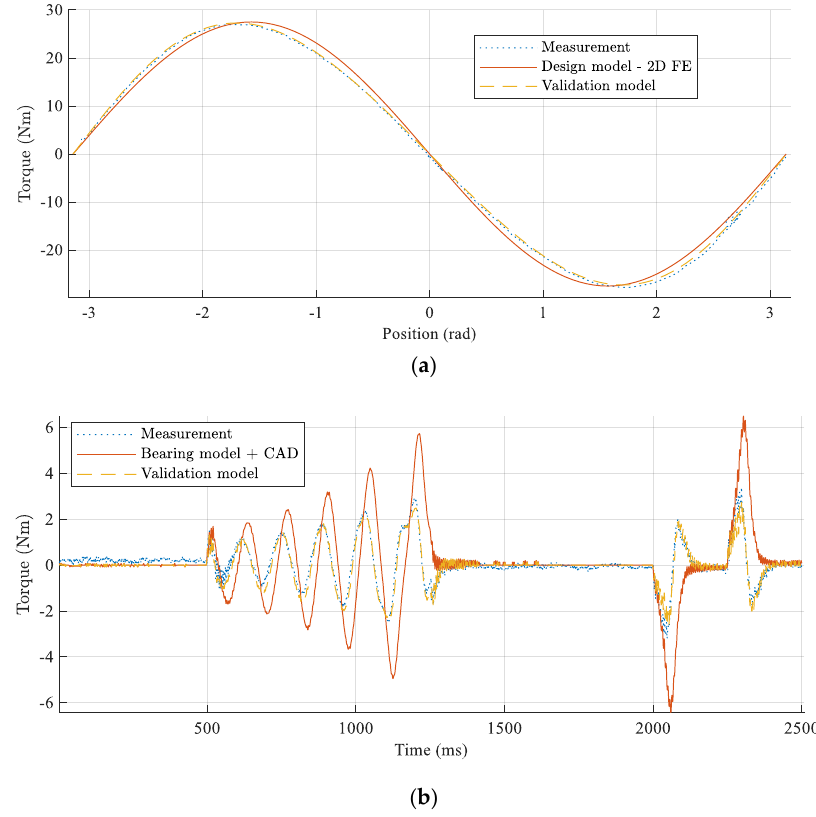
Figure 8. Component validation ( a ) static measurement of magnetic spring torque characteristic ( b ) dynamic measurement for identification of spring inertia and losses.